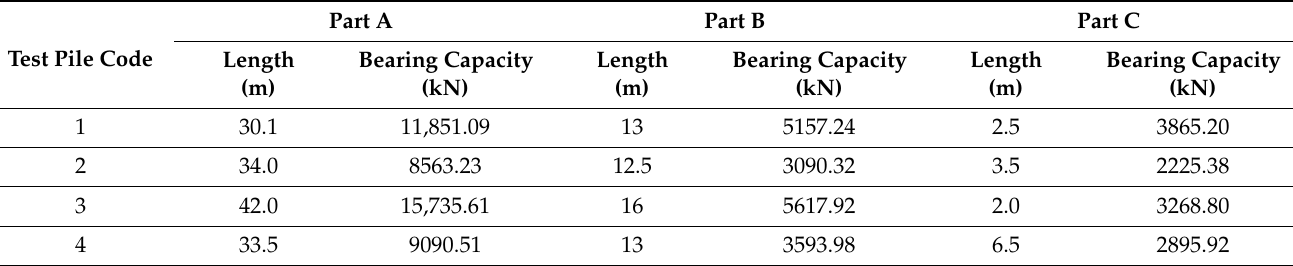
Table 3. Test pile length and estimated bearing capacity.